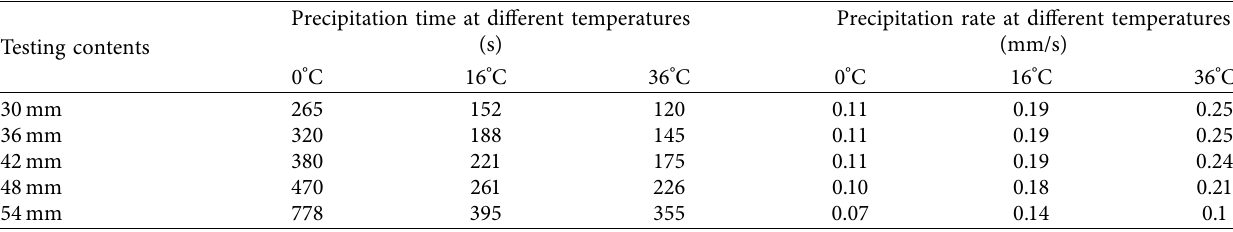
Table 5: Precipitation time and speed of mixed slurry of fly ash and clay.